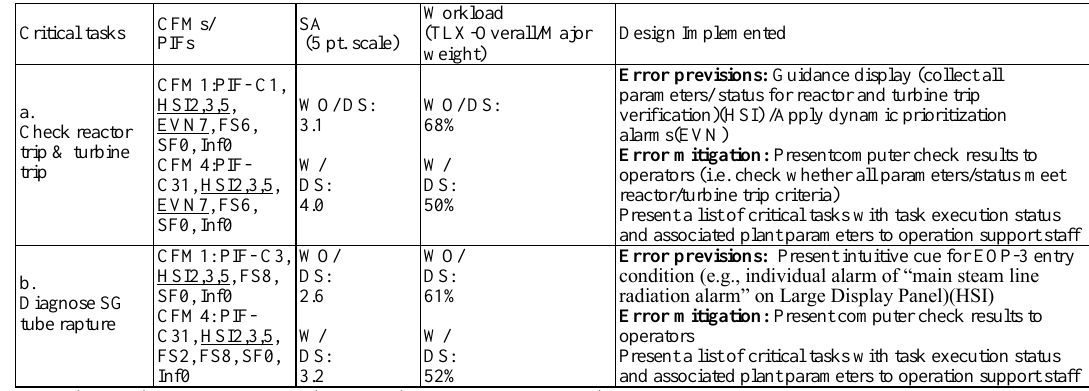
Table 4. Summary of design